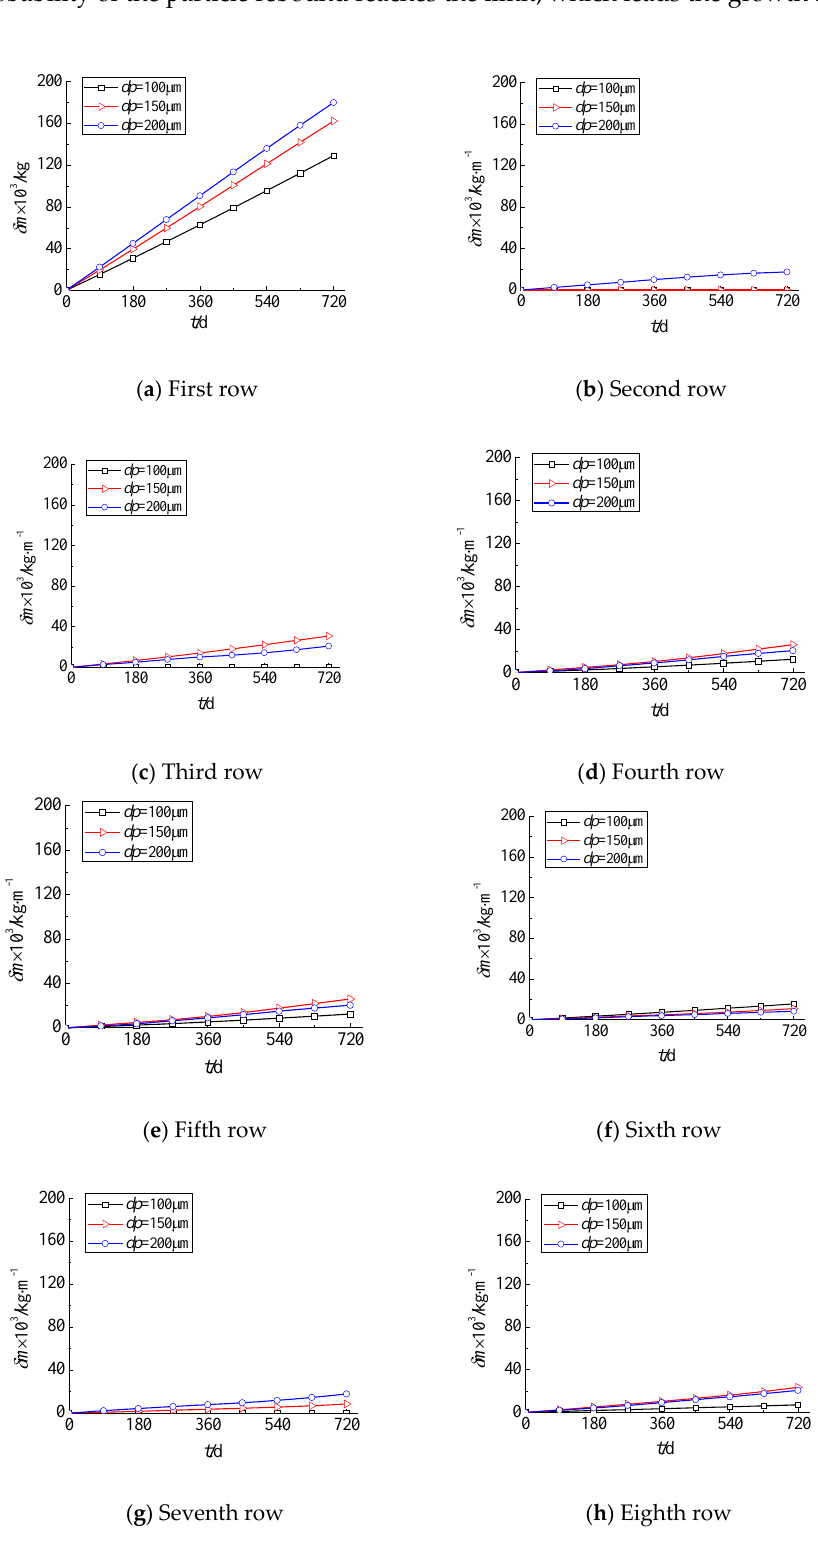
Figure 10. Local erosion loss under different ash sizes.